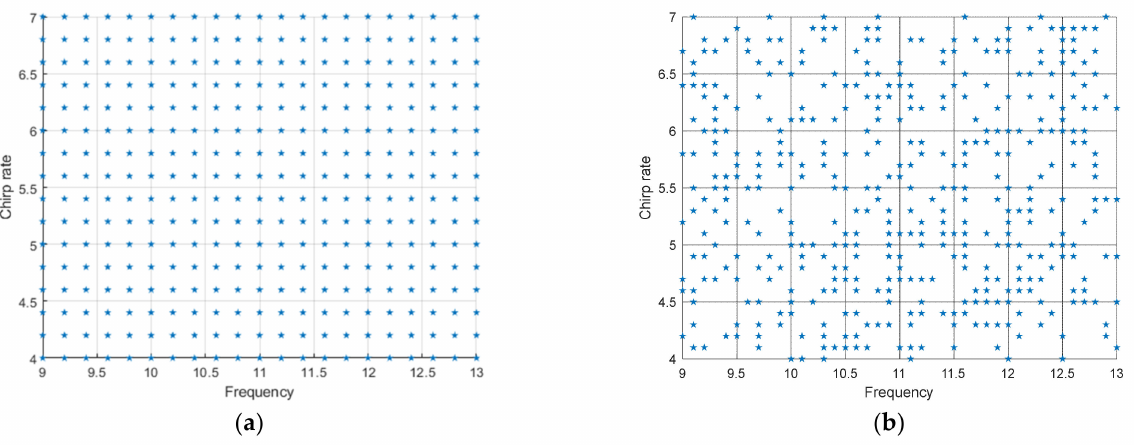
Figure 6. Training set and test set parameter distribution diagram. ( a ) describes the training set, ( b ) describes the test set.